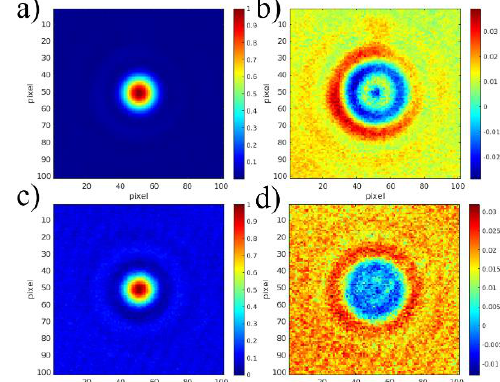
Fig. 3. Averaged, focal dot measurements and evaluation for an unsuccessful (a, b) and a successful (c, d) alignment of the